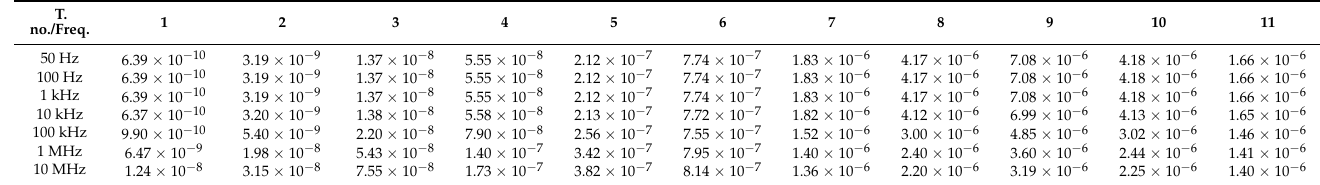
Table A8. Self and mutual inductances of turn 11 (in H) resulting from FEM simulations. T. no./Freq.